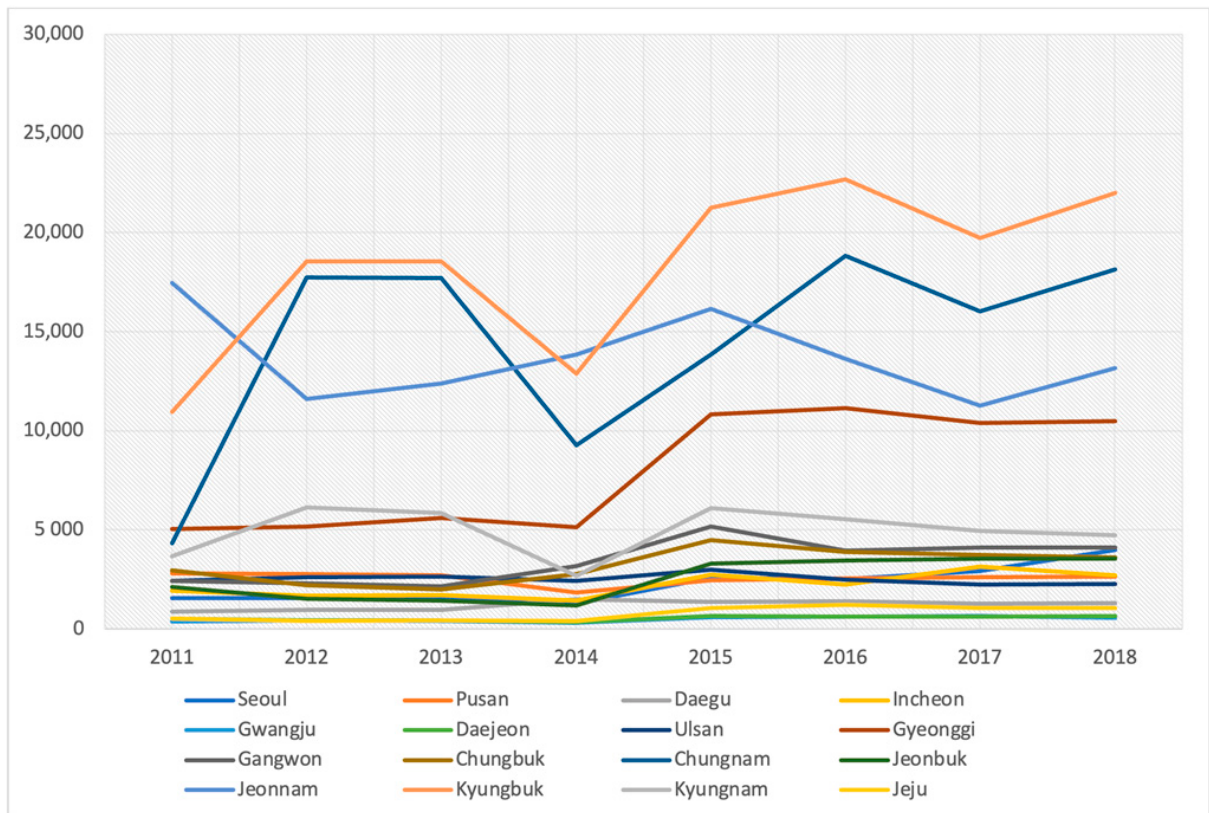
Figure 2. Air pollution trend (PM2.5) in local governments (Ton) [1] .